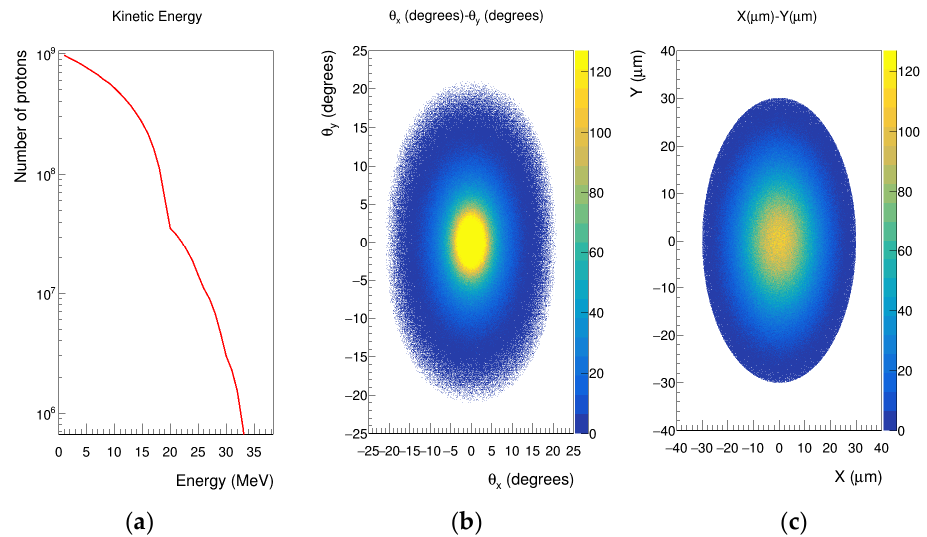
Figure 1. Distributions of the implemented source: ( a ) Initial kinetic energy distribution following the data presented in Dover et al. [30]; ( b ) Initial angular distribution. Protons at different energies have a maximum half-angle between 2.4 (highest energy) and 21 (lowest energy) degrees according to the data presented in Dover et al. [30]; ( c ) Initial position of the protons in the XY plane.